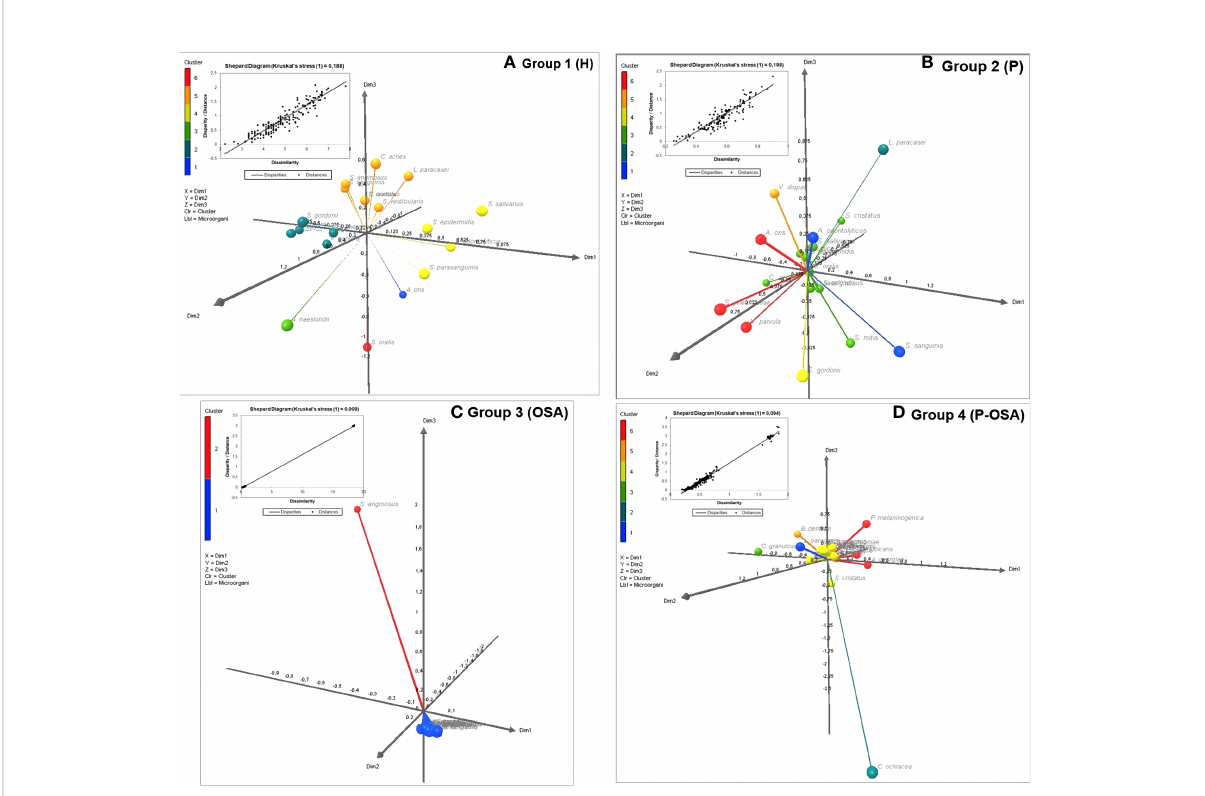
FIGURE 5 Multidimensional Scaling (MDS) based on Proximity Matrices (Euclidean Distance) and Kruskal Stress for the three-dimensional visualization (XLSTAT3DPlot) of the consortia made up of the most common microorganisms by group of patients: (A) Group 1 (H) ; (B) Group 2 (P); (C) Group 3 (OSA); (D) Group 4